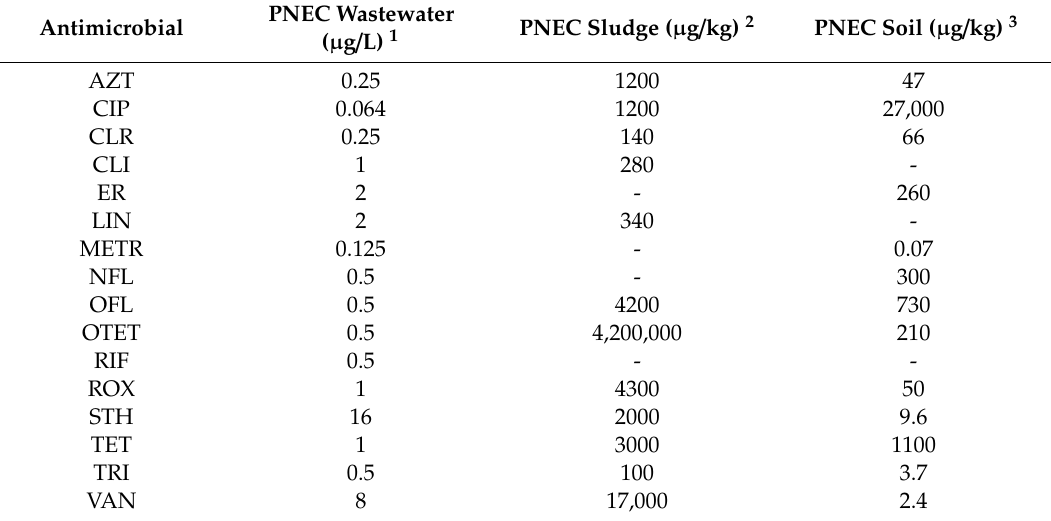
Table A5. Predicted no e ff ect concentration values for resistance selection of microbial community in wastewater, sludge, and